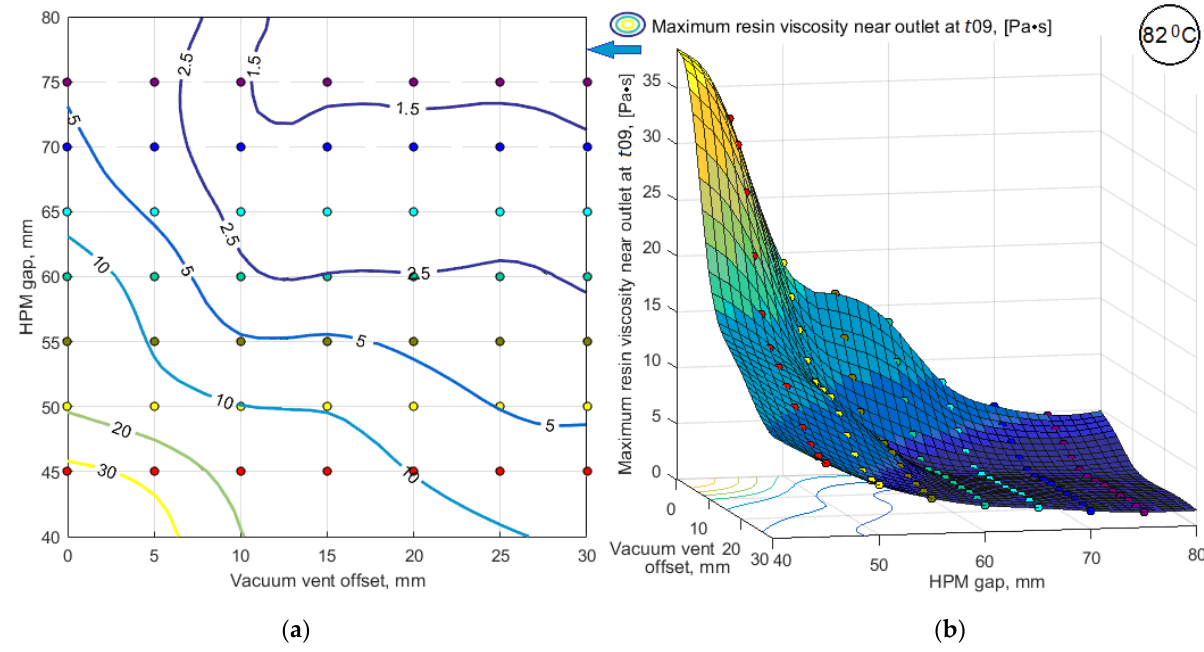
Figure 13. The response function of the predicted maximum resin viscosity in the vicinity of the vacuum vent max( µ out ( t 09)) in the form of: ( a ) map of level lines; ( b ) smoothed 3D